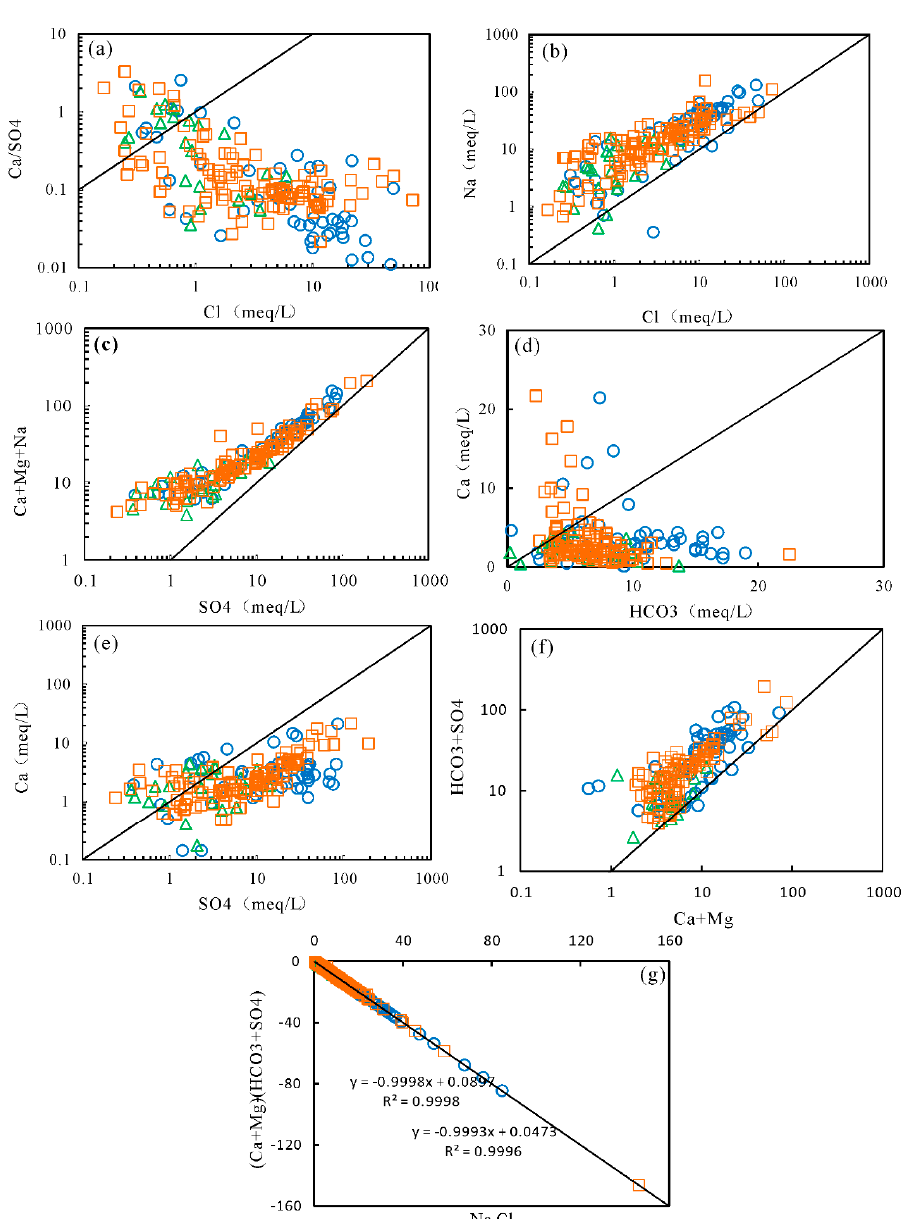
Figure 7. Scatter plots of major ions in groundwater; ○ , shallow groundwater; ∆ , intermediate groundwater; □ , deep groundwater; ( a ) PCa 2+ /SO 42 − ratios versus Cl − , ( b ) Na + versus Cl − , ( c ) Ca 2+ + Mg 2 + + Na + versus SO 42 − , ( d ) Plot of Ca 2 + against HCO 3 − , ( e ) Plot of Ca 2 + against SO 42 − , ( f ) Ca 2 + + Mg 2 + versus SO 42 − + HCO 3 − , and ( g ) (Ca 2 + + Mg 2 + )-(SO 42 − + HCO 3 − ) versus Na + -Cl − . The symbols were kept the same hereafter if there are no special